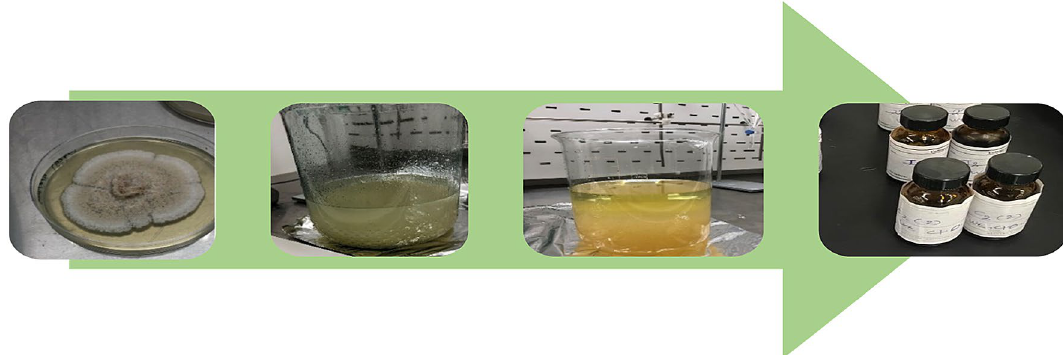
Figure 1. Images show the process of fungal